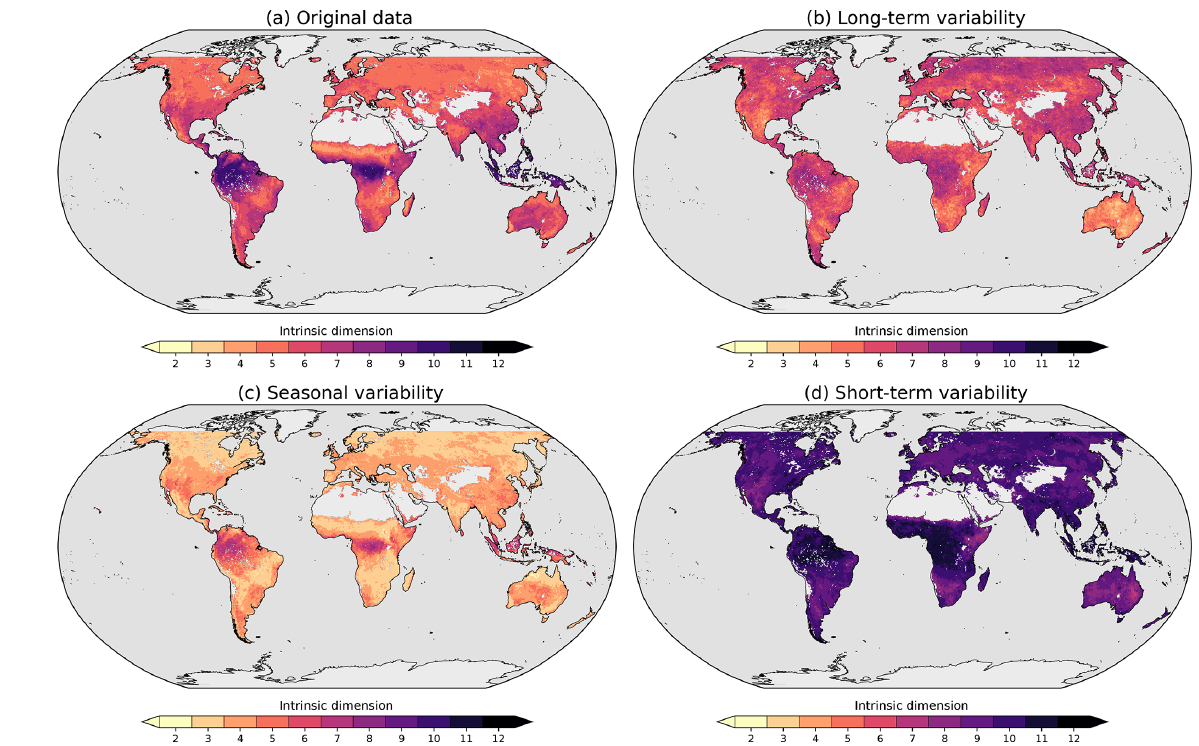
Figure 5. Intrinsic dimension of 18 land ecosystem variables. The intrinsic dimension is estimated by counting how many principal com- ponents would be needed to explain at least 95% of the variance in the Earth system data cube. The results for the original data are shown in panel (a) . The analysis is then repeated based on subsignals of each variable, representing different timescales. In panel (b) , we show the intrinsic dimension of long-term modes of variability, in (c) for modes representing seasonal components, and (d) for modes of short-term variability. Light grey areas indicate zones where at least one data stream was incomplete and no intrinsic dimension could be estimated based on the same set of